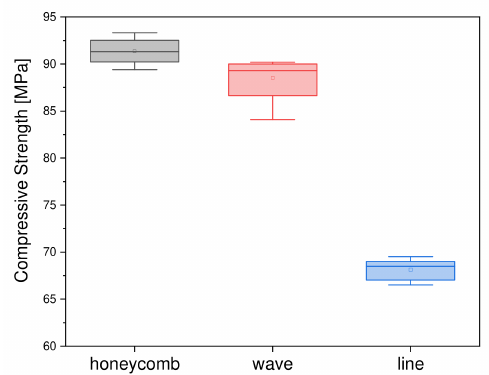
Figure 9. Boxplot of compressive strength as a function of outer and inner geometry (round